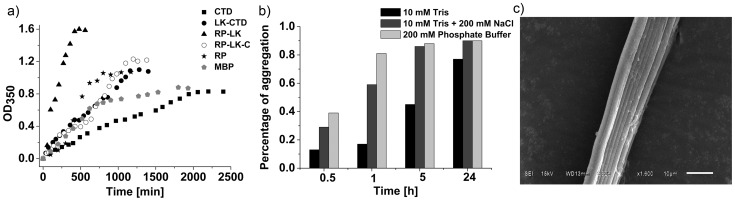
Shear-force-induced aggregation of MiSp fragments and MBP monitored by OD350 (a), dependence of aggregation of RP-LK-CTDMi on salts (b), and SEM of silk fibers formed by RP-LK-CTDMi (c).The scale bar is 10 µm.